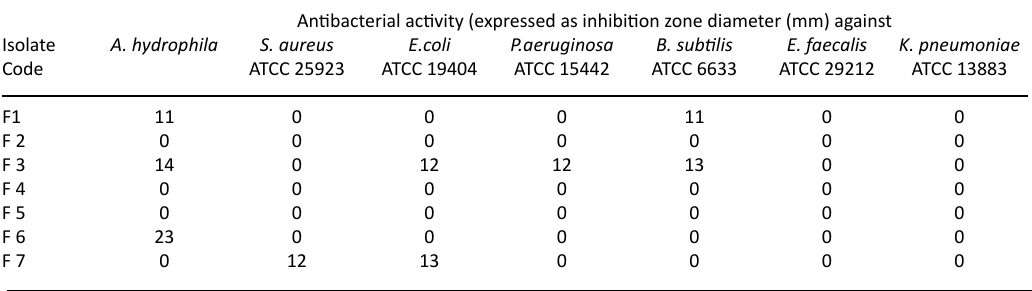
Table 1. Antibacterial potential of the isolated marine fungi against different reference pathogenic indicators Antibacterial activity (expressed as inhibition zone diameter (mm) against Isolate